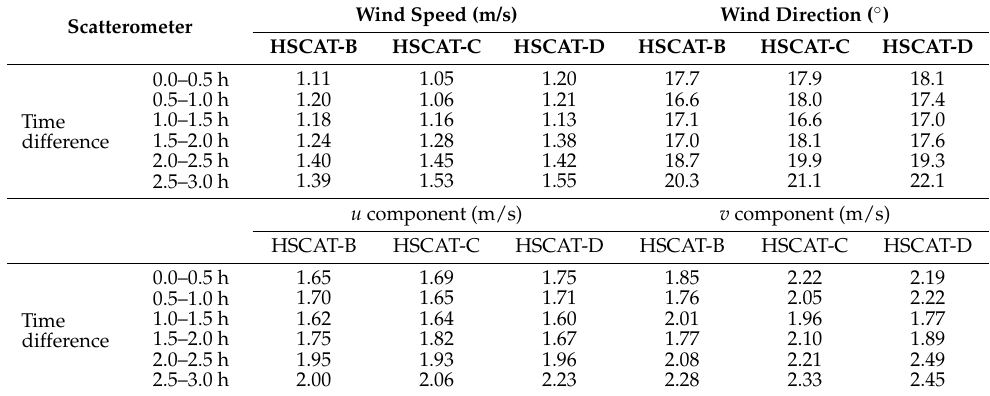
Table 3. SD differences of the HSCATs winds with regards to. buoy measurements for different time windows.